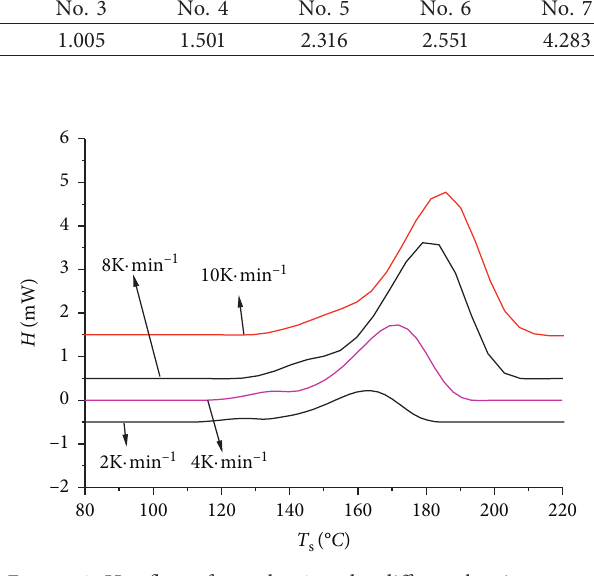
Figure 2: Heatflow of sample #2 under different heating rates. Table 4: Results for 40% DCP with the DSC